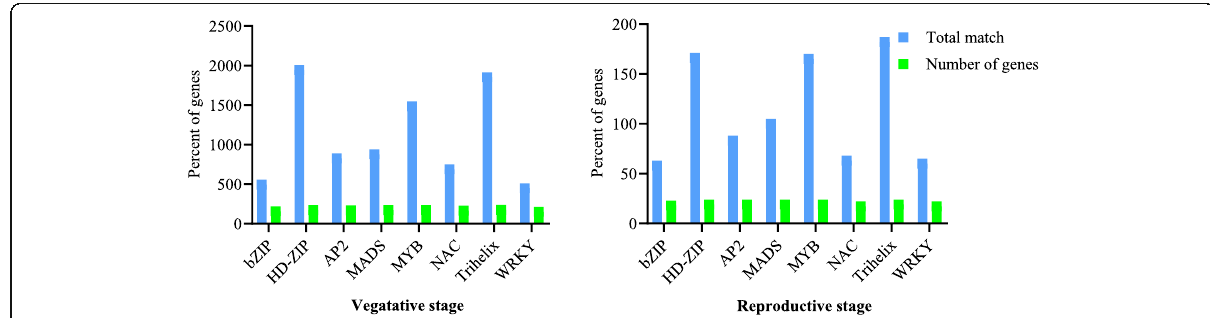
Fig. 5 Transcription factor families with binding sites in more than 85% ( P value < 0.05) of the drought-responsive genes. Blue bar, the number of binding sites of these transcription factors predicted in the promoters of the DEGs; green bar, the number of genes having binding sites of these transcription factors in the